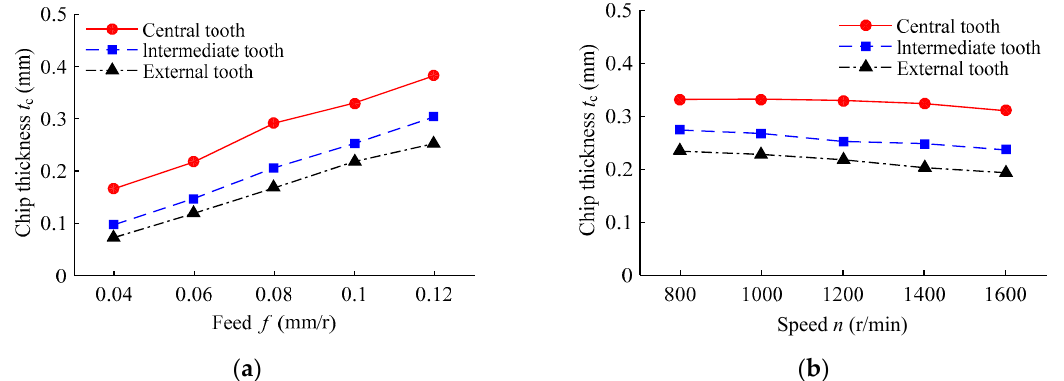
Figure 8. The effect of drilling process parameters on chip thickness: ( a ) under different drilling feeds at a speed of 1200 r/min; ( b ) under different drilling speeds at a feed of 0.1 mm/r.